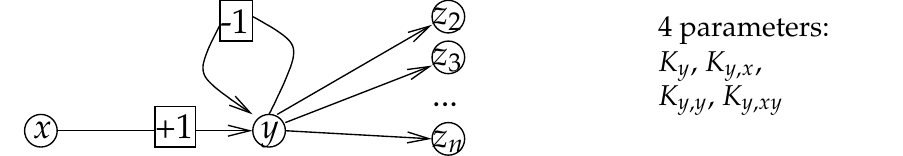
Figure 2. Anothertoy example. ( Left ): A partial view of an influence graph where y inhibits itself Figure 2. Another toy example. Left: A partial view of a influence graph where y inhibits itself and is